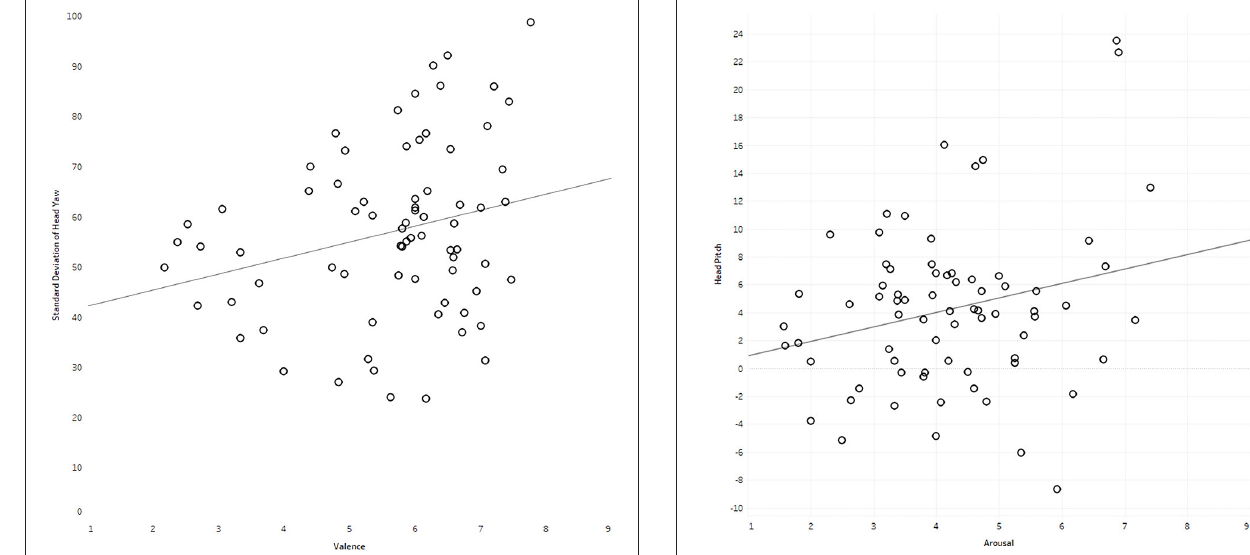
FIGURE 6 | Plot illustrating relationship between standard deviation of head yaw and valence ratings.